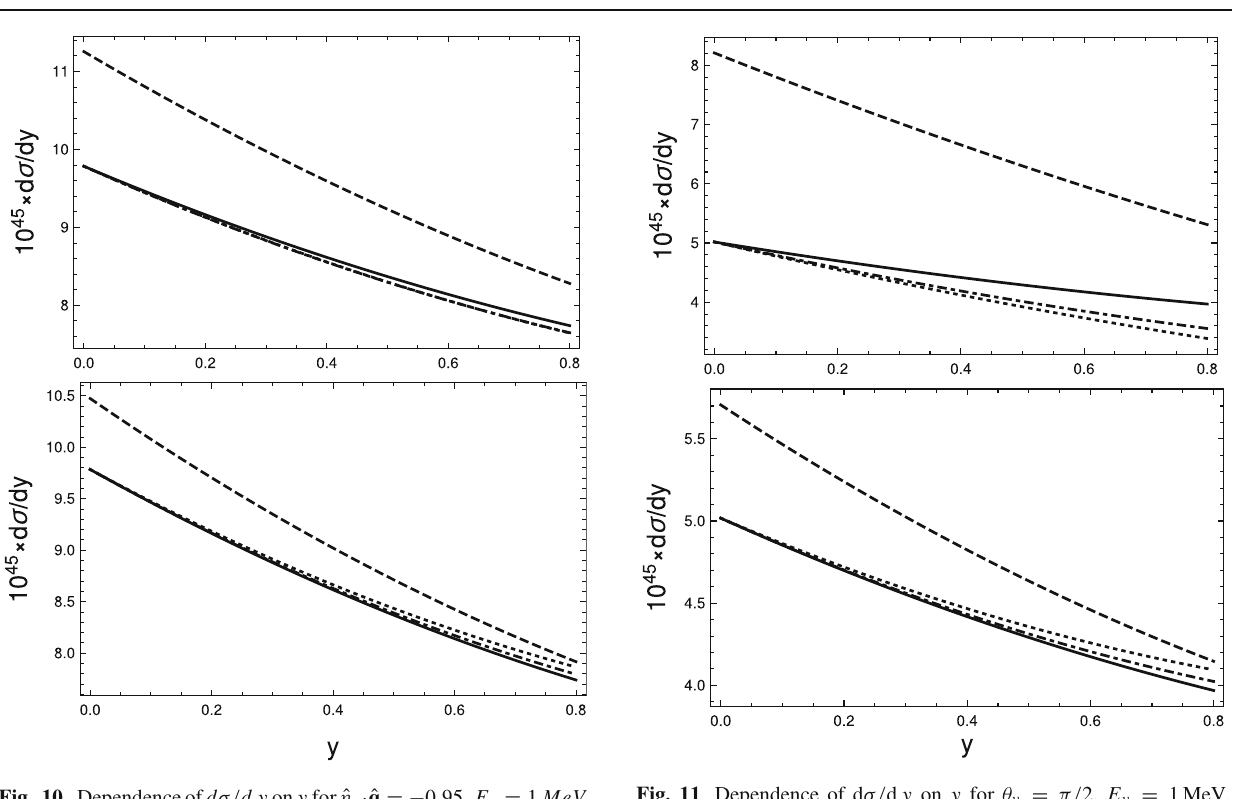
Fig. 11 Dependence of d σ/ d y on y for θ ν = π/ 2, E ν = 1MeV, Fig. 10 Dependenceof d σ/ d y on y for ˆ η ν ·ˆ q = − 0 . 95 , E ν = 1 MeV , φ ν = 0. Upper plot for TRSC: standard V − A interaction (solid line); φ ν = 0. Upper plot for TRSC: standard V − A interaction (solid line); | = 0 . 2 ,θ = 0 (dashed | = 0 . 2 ,θ = 0 (dashed the combination of V − A and T R when | c R the combination of V − A and T R when | c R T , R T , R T T | = 0 . 2 ,θ = 0(dottedline); | = 0 . 2 ,θ = 0(dottedline); line);thecaseof V − A and S R when | c R line);thecaseof V − A and S R when | c R S , R S , R S S | = 0 . 2 ,θ = 0 (dashed-dotted line). Lower | = 0 . 2 ,θ = 0 (dashed-dotted line). Lower V − A with P R when | c R V − A with P R when | c R P , R P , R P P plot for TRSV: standard V − A interaction (solid line); the combination plot for TRSV: standard V − A interaction (solid line); the combination | = 0 . 2 ,θ = π/ 2 (dashed line); the case | = 0 . 2 ,θ = π/ 2 (dashed line); the case of V − A and T R when | c R of V − A and T R when | c R T , R T , R T T | = 0 . 2 ,θ = π/ 2 (dotted line); V − A | = 0 . 2 ,θ = π/ 2 (dotted line); V − A of V − A and S R when | c R of V − A and S R when | c R S , R S , R S S | = 0 . 2 ,θ = π/ 2 (dashed-dotted | = 0 . 2 ,θ = π/ 2 (dashed-dotted line) with P R when | c R with P R when | c R P , R P , R P P